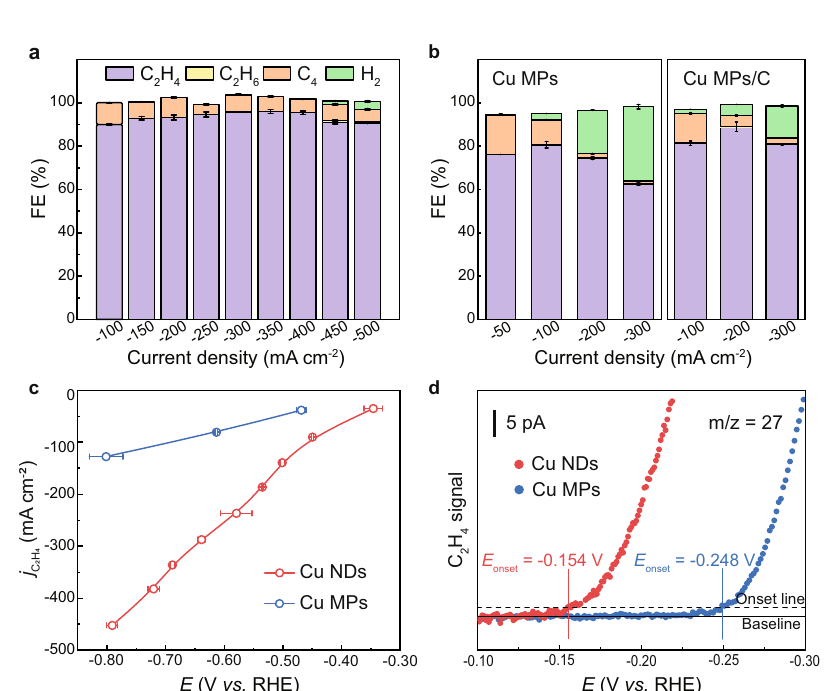
Fig. 2 | Electrocatalytic acetylene semihydrogenation performance over Cu- based electrocatalysts under pure acetylene fl ow. a , b FEs of EASH products at different current densities of a Cu NDs and b Cu MPs, Cu MPs/C. c Variation in the ethylenepartialcurrentdensityagainstappliedpotentialoverCuNDsandCuMPs.